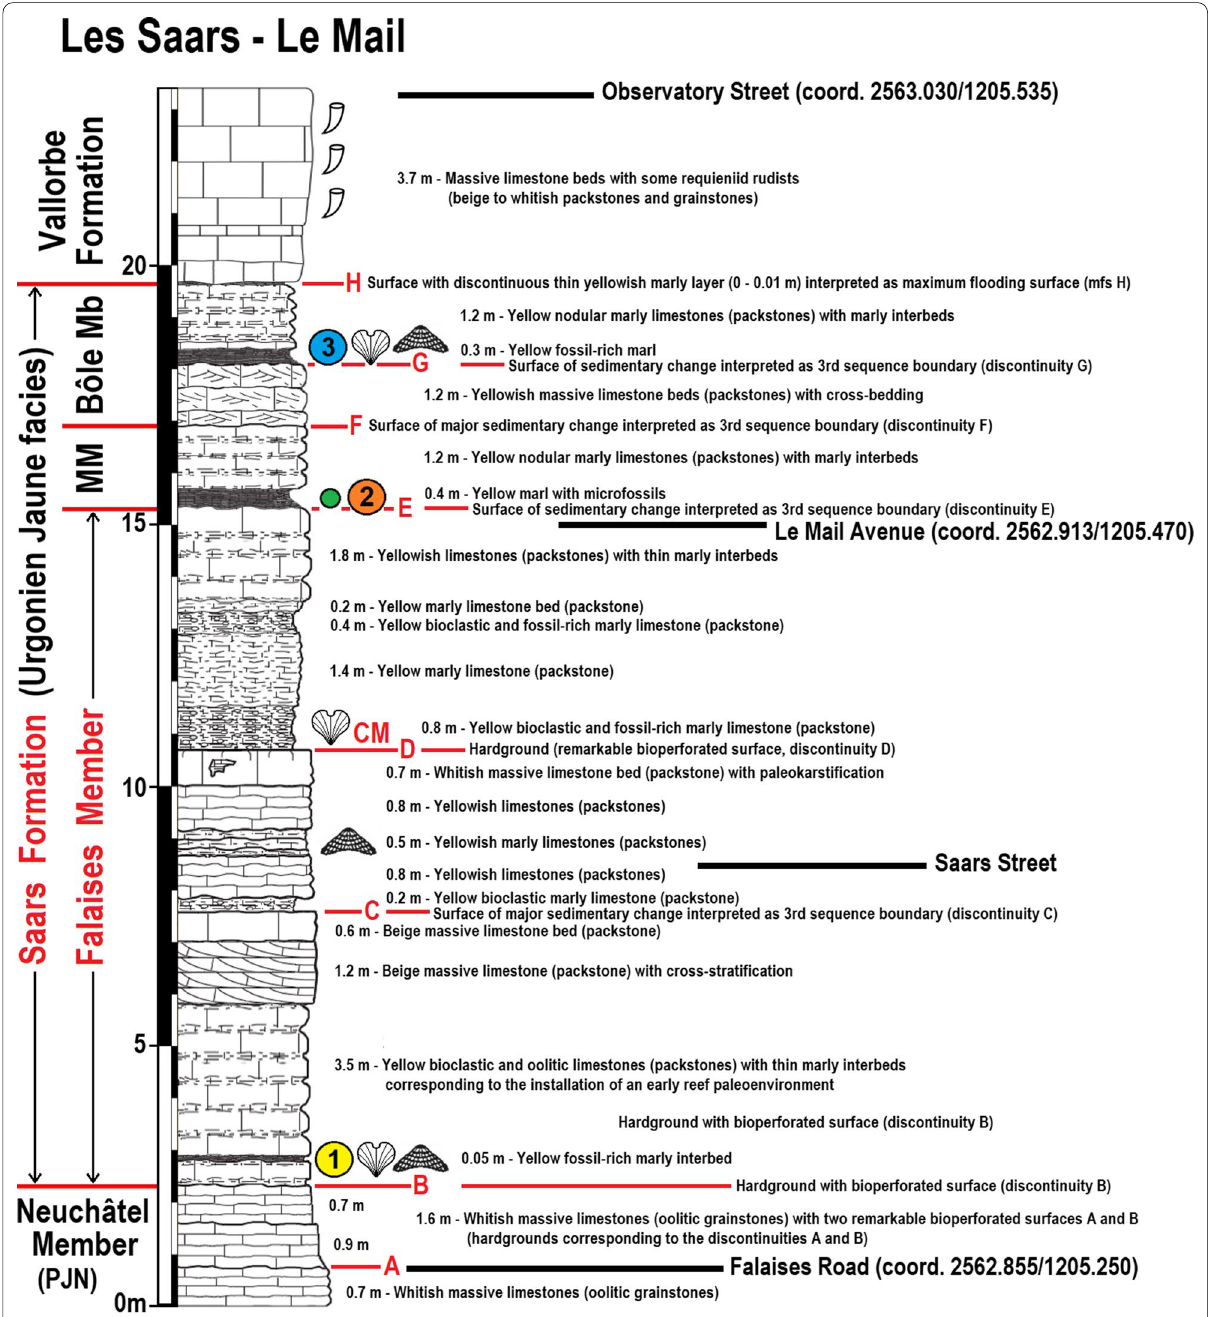
Fig. 3 Type section of the Saars Formation (Urgonien Jaune facies) in the central Jura Mountains (Les Saars‑Le Mail section, Neuchâtel City), see Figs. 4, 5, 6, 7, 10, 11. Abbreviations: PJN: Pierre Jaune de Neuchâtel (facies); MM: Montcherand Member; Bôle Mb: Bôle